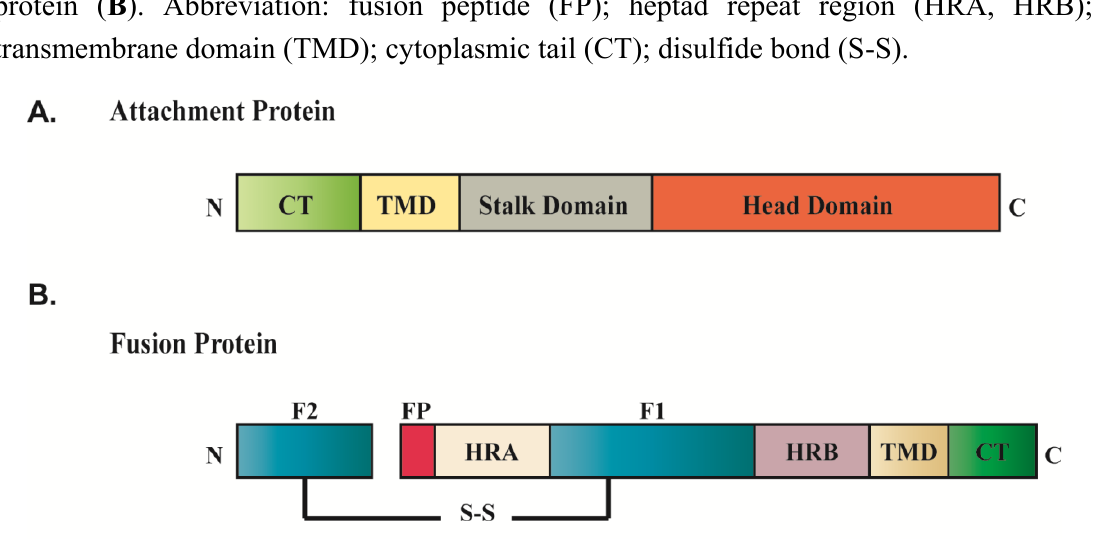
Figure 2. Conserved domain structures of paramyxovirus fusion protein ( A ) and attachment protein ( B ). Abbreviation: fusion peptide (FP); heptad repeat region (HRA,